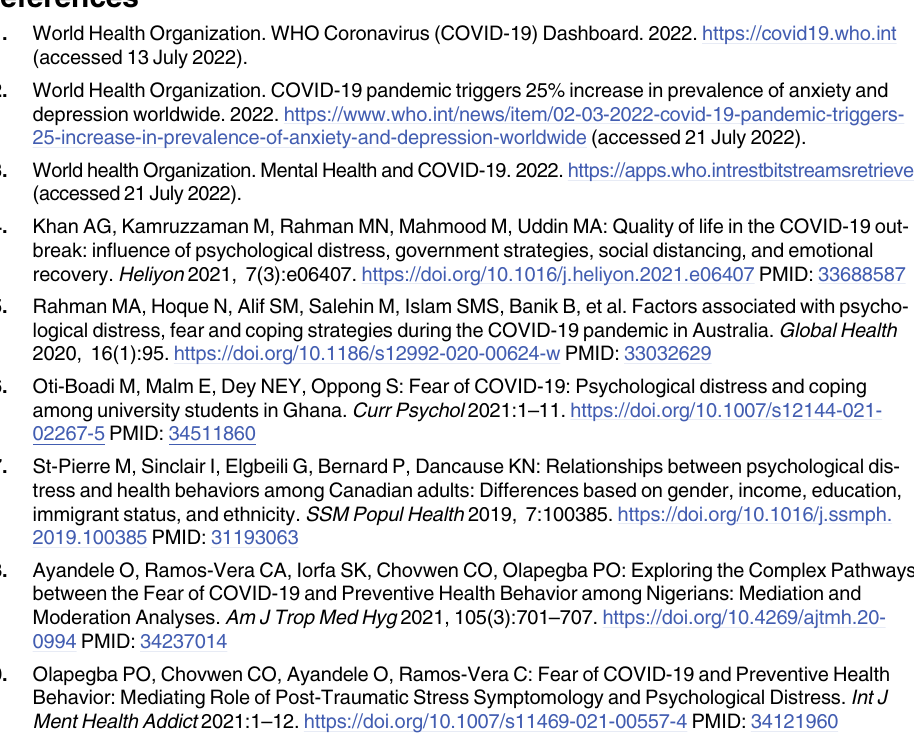
S1 Fig. Scale information and conditional standard errors. (TIFF) S2 Fig. Scale characteristic curve.